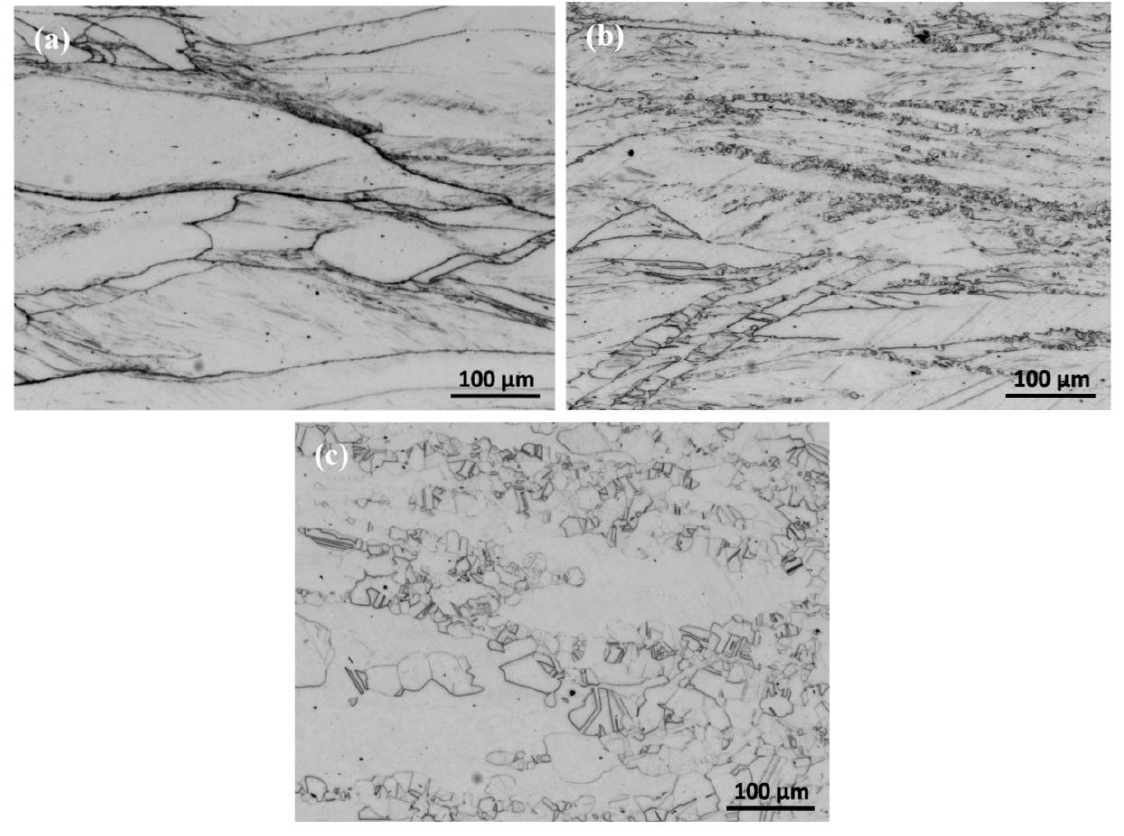
Figure 7. Microstructure of a specimen deformed at ( a ) 1173 K, with a strain rate of 0.1 s −1 (point marked as a in Figure 6); ( b ) 1273 K, with a strain rate of 10 s −1 (point marked as b in Figure 6) and ( c ) 1373 K, with a strain rate of 1 s −1 (point marked as c in Figure